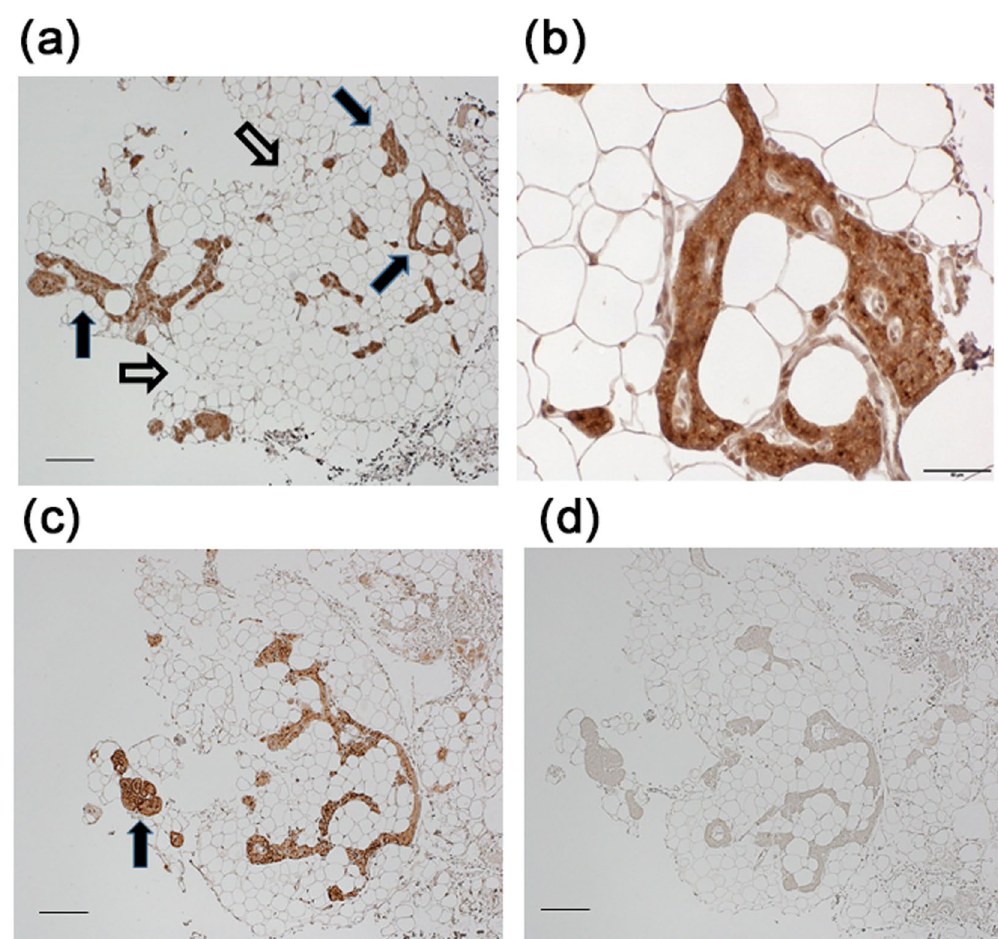
Figure 2. Immunohistochemistry for PTH-expressing cells in adipose tissues surrounding the parathyroid glands of secondary hyperparathyroidism patients. Adipose tissues surrounding the parathyroid glands of secondary hyperparathyroidism patients were stained with anti-PTH or anti-GCM2 antibody. Nuclei were stained with hematoxylin. Representative specimens are shown. Filled arrows indicate colonies of PTH- or GCM2-expressing cells. Empty arrows indicate adipocytes. (a) stained with anti-PTH antibody. A low- magnification view. Bar, 200 μ m. (b) an enlarged view of a part of ( a ). Bar, 50 μ m. (c) stained with anti-GCM2 antibody. A low-magnification view. Bar, 200 μ m. (d) a negative control stained without primary